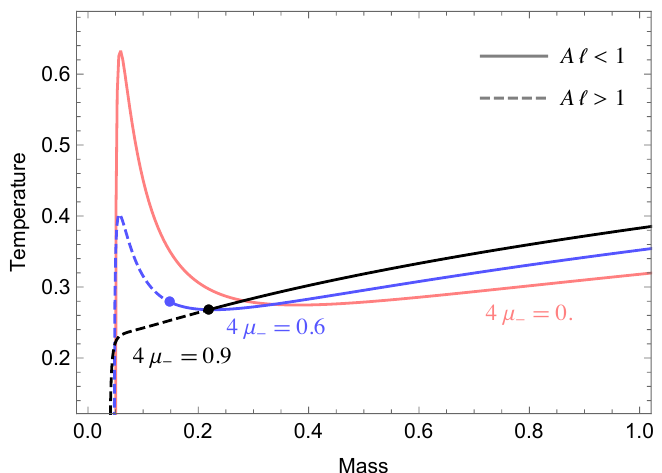
Figure 4 . A plot of temperature as a function of mass for the charged black hole, with (cid:12)xed Q = 0 : 05 ‘ , and varying tension as labelled. As before, the slowly-accelerating r(cid:19)egime is shown as a solid line, and A‘ > 1 is shown